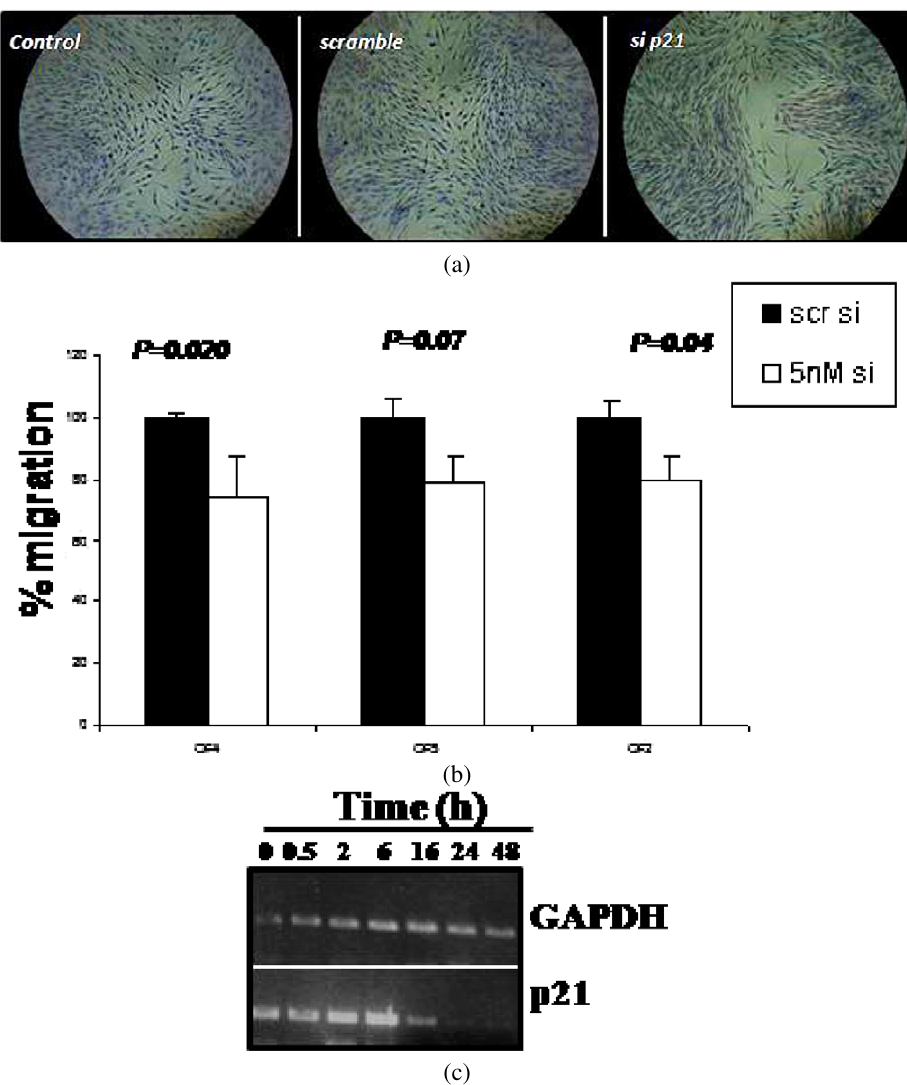
Fig. 3. (a) Representative microphotographs of cell migration during p21-knockdown by siRNA. Effect of scrambled RNA at 5 nM is also shown. (b) Graphical presentation of cell migration during p21-knockdown. p21-knockdown resulted in the decrease of cell migration. (c) RT-PCR analysis of p21 expression in fibroblasts co-cultured with MCF7 breast cancer cells in 0.4 µ pore size transwells